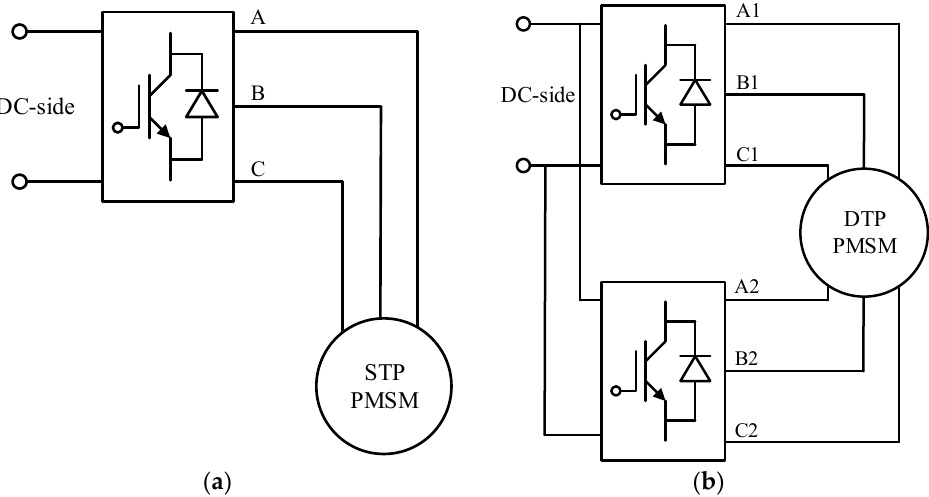
Figure 6. Schematics of drive systems for different winding configurations: ( a ) ORG; ( b ) DTP-SF; DTP-DS.